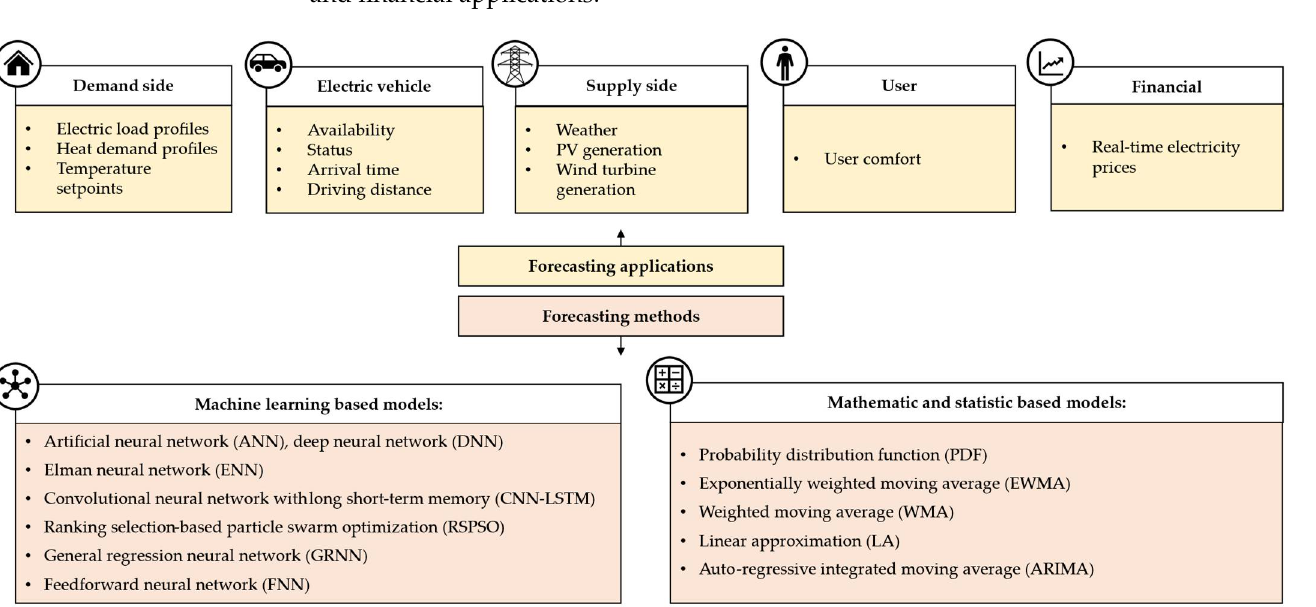
Figure 4. Forecasting algorithms and applications for energy management systems .